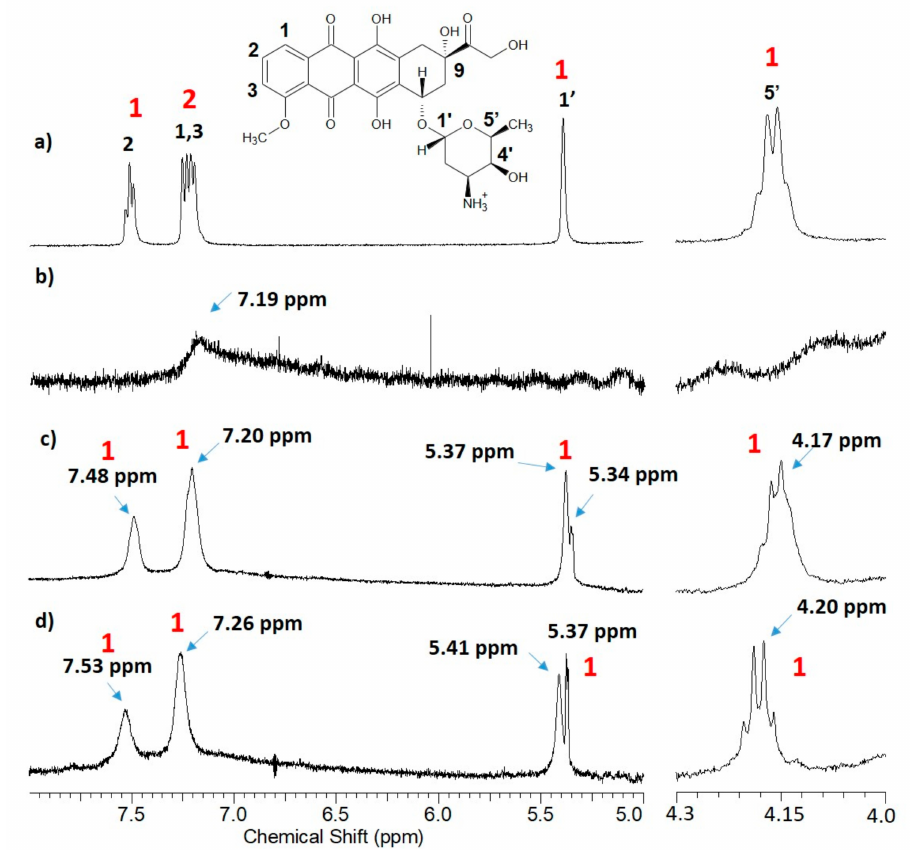
Figure 5. 1 H-NMR spectra in D 2 O, 4–8 ppm: ( a ) Doxorubicin (5 mg); ( b ) Compound 3a in water; ( c ) Doxorubicin mixed with 3a (5 mg + 5 mg); ( d ) Doxorubicin mixed with 3a aged 25